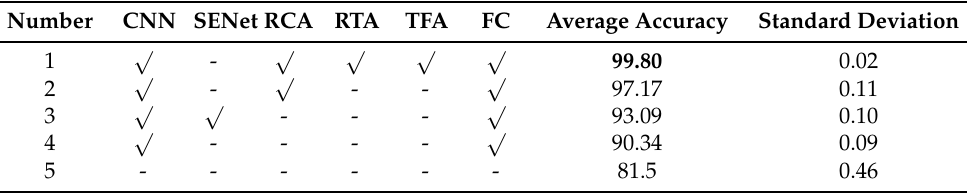
Figure 6. Gradient–weighted class activation mapping for different fault samples: ( a ) normal; ( b ) inner race fault; ( c ) outer race fault. Table 4. Identification results of different combination